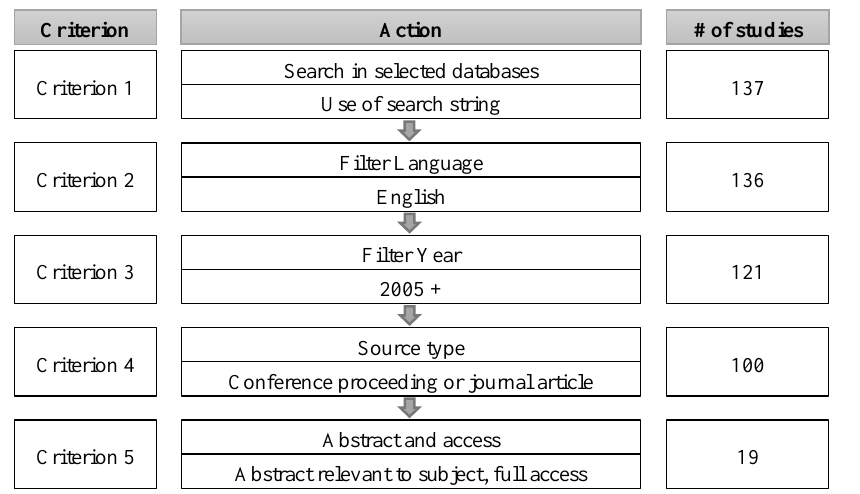
Figure 3. Literature search